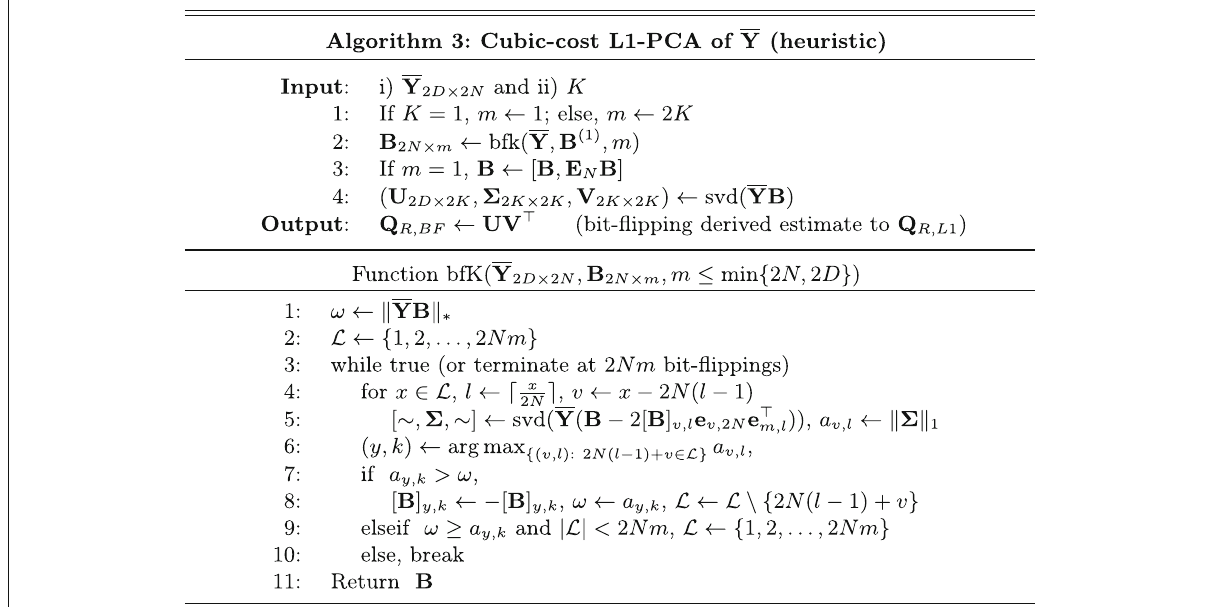
(cid:9) (cid:12) N 3 m 4 ( m = 1 for